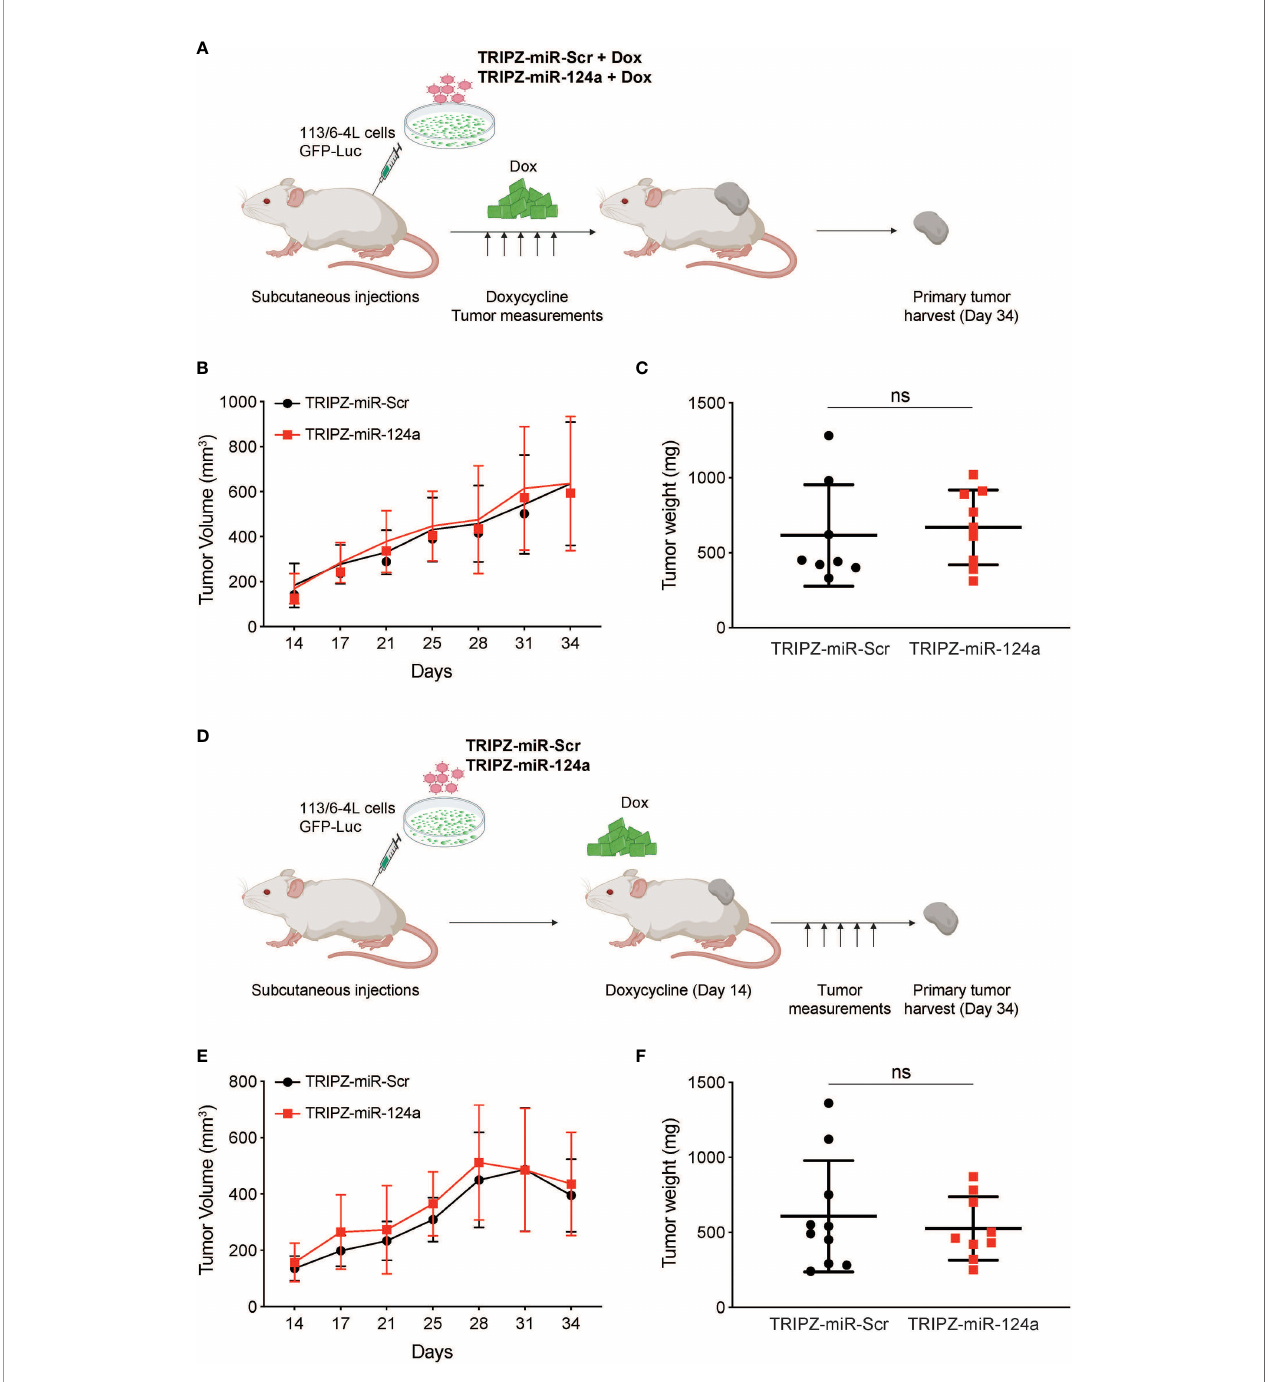
FIGURE 4 | miR-124a overexpression does not inhibit subcutaneous tumor formation nor established tumor growth. (A) Schematic representation of in vivo tumor growth model: The 113/6-4L -GFP-Luciferase cells were stably transduced with doxycycline-inducible control TRIPZ-miR-Scr or TRIPZ-miR-124a tagged with a tRFP reporter and injected with Matrigel (1:1) into the fl ank of NSG female mice. Cells were treated with doxycycline (2 µg/ml) prior to injection, and mice were fed doxycycline chow since the intracardiac inoculation. (B) Constitutive miR-124a overexpression in 113/6-4L cells did not affect tumor volume (C) nor weight at termination of the experiment (Day 34). (D) Schematic representation of in vivo growth after implantation: The 113/6-4L -GFP-Luciferase cells were stably transduced with doxycycline-inducible control TRIPZ-miR-Scr or TRIPZ-miR-124a tagged with a tRFP reporter and injected with Matrigel (1:1) into the fl ank of NOG/SCID female mice. Once tumors were palpable (Day 14 post-injection), mice were fed doxycycline chow (200 mg/kg). (E) Inducible miR-124a overexpression in established tumors did not affect tumor volume (F) nor weight at termination of the experiment (Day 34). ns, non signi fi